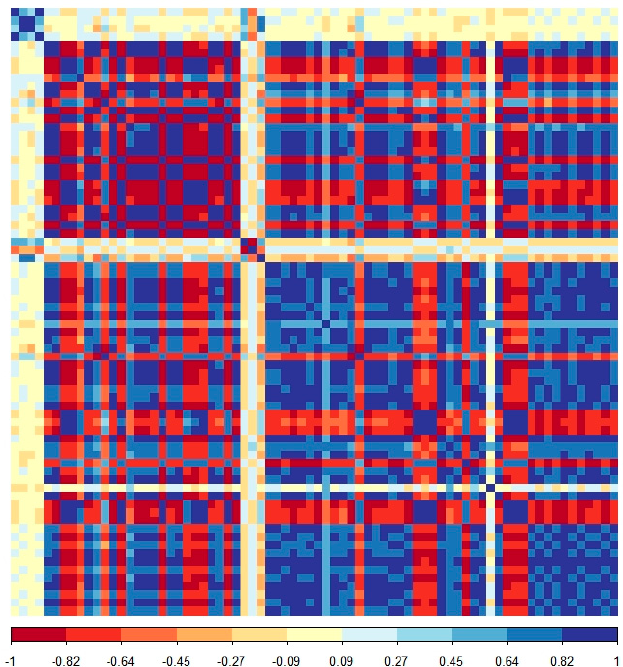
Figure A1. Correlation matrix of the radiomics features using Spearman coefficients of correlation.